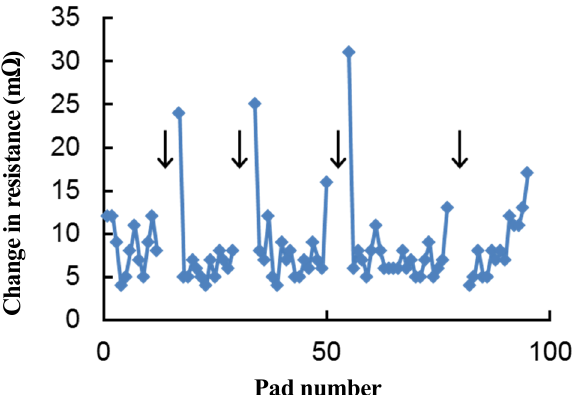
Figure 19. Change in resistance of the film-type connection in the unbent condition after 1000 bending cycles for a curvature radius of 2.5